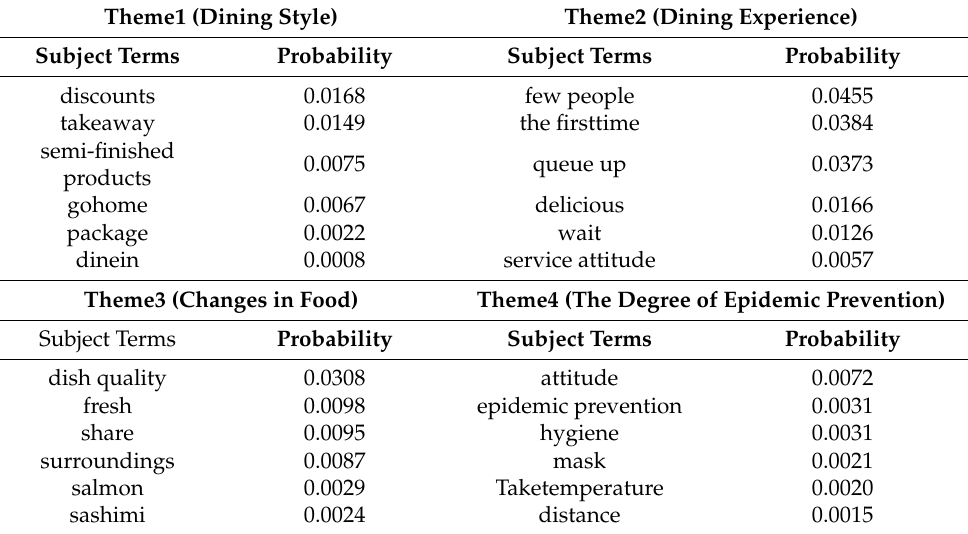
Table 9. Four post COVID-19 topic models based on LDA